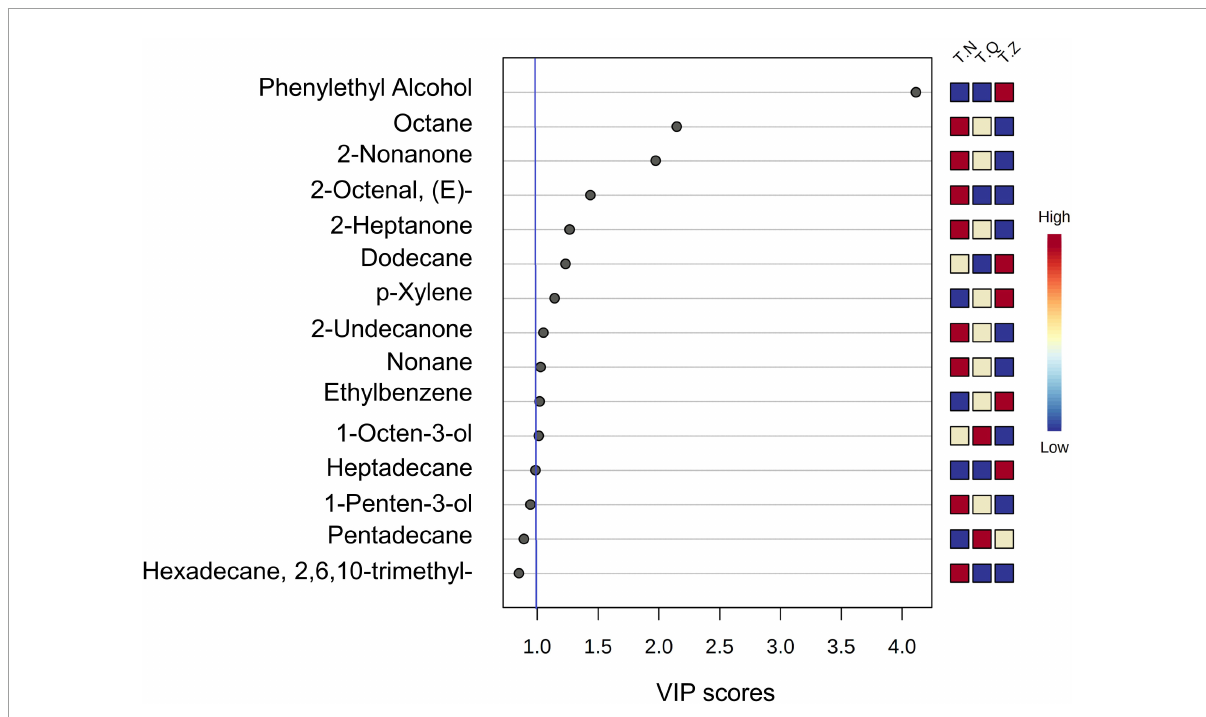
FIGURE5 The VIP graph of PLS-DA of all relevant volatiles analyzed in the multivariate data set.